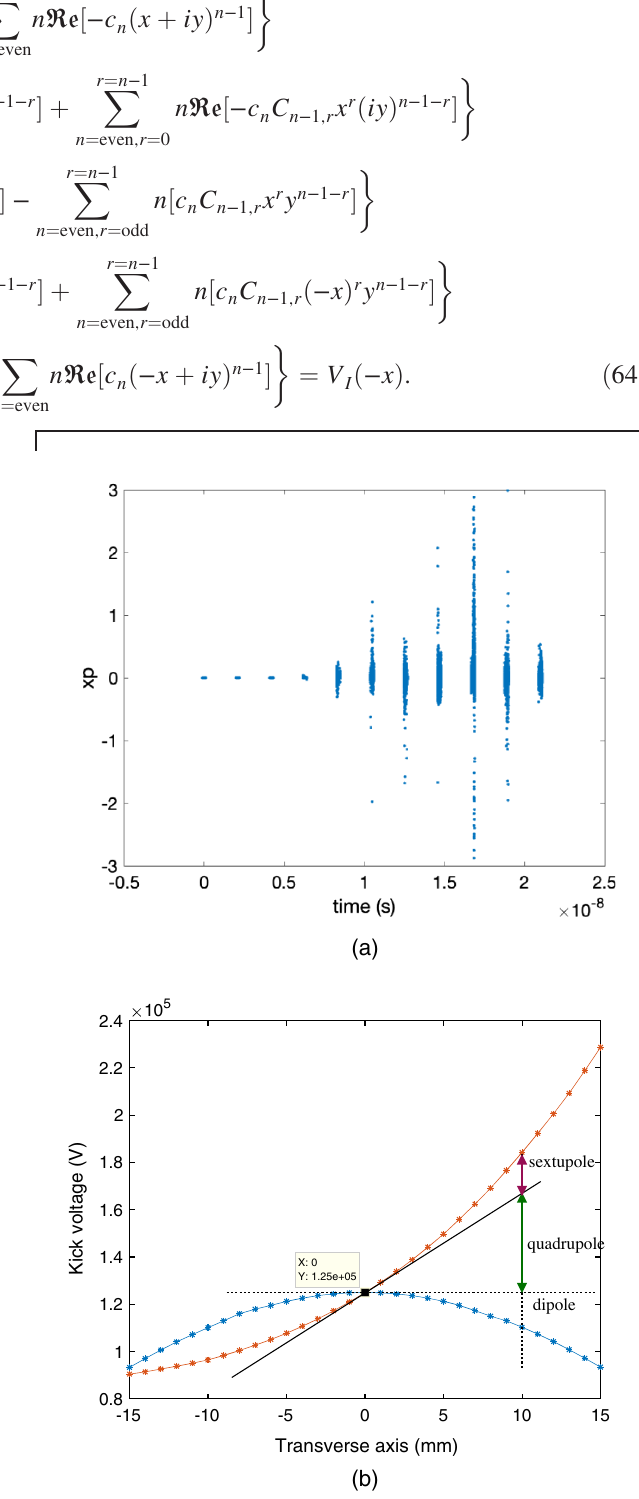
FIG. 9. Multipole effects of the kicker without a cancellation scheme. (a) Longitudinal profiles of electron bunches with multi- poles (without any cancellation scheme), showing a blow-up in angular divergence. (b) Integrated Lorentz force at various offsets. The red (blue) curve is along the vertical (horizontal)